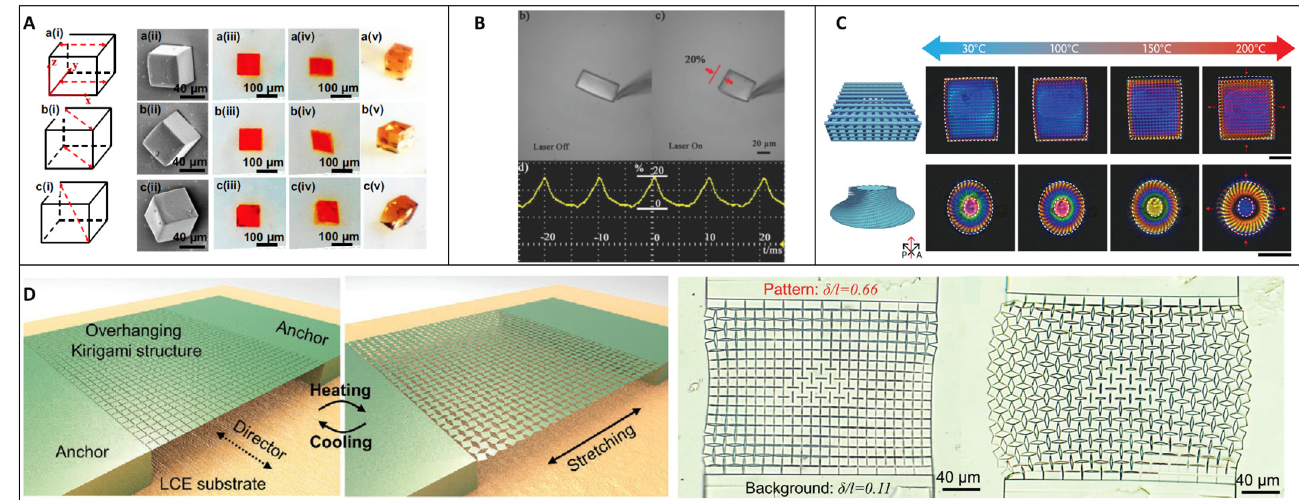
Figure 6. ( A ) Micrometric blocks with various orientations for millimetric-responsive structure con-